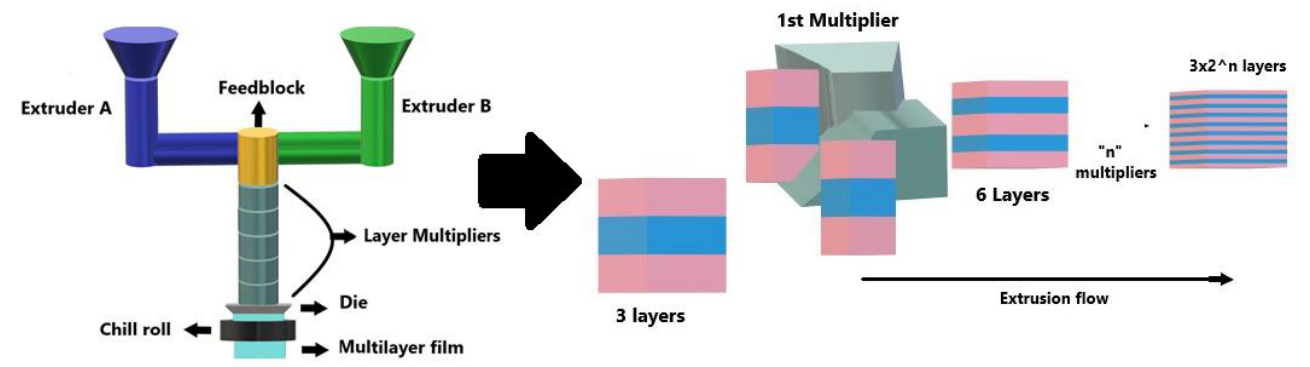
Figure 1. Schematic illustration of layer multiplication in the homemade multilayer coextrusion setup. For the B/A/B feedblock configuration, two PE/PP systems were extruded: (a) PP/PE/PP, and (b) PP/PE + 7 wt% EOC/PP, with a volumetric flow of 90/10. Meanwhile, for the PE/PS systems, with the B/A feedblock configuration, films with volumetric flows of 50/50 and 10/90 were obtained, keeping the total thickness of the film constant around 200 µ m.